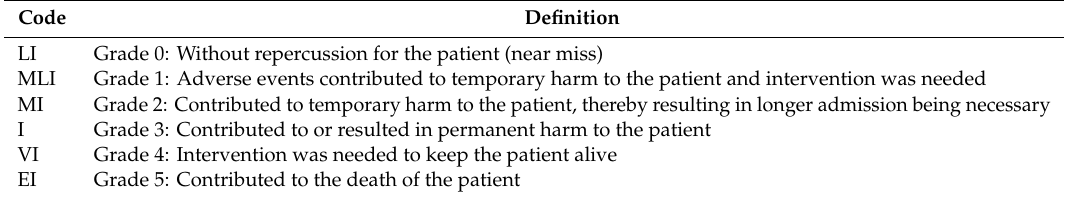
Table 3. Severity Scale (Adapted from [84]).